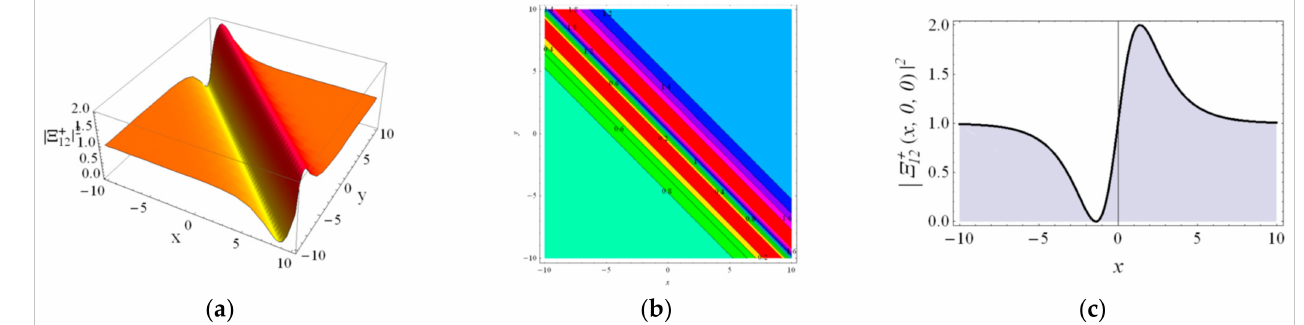
(cid:12) (cid:12) 2 with the parameters ε (cid:12) Ξ + (cid:12) 12